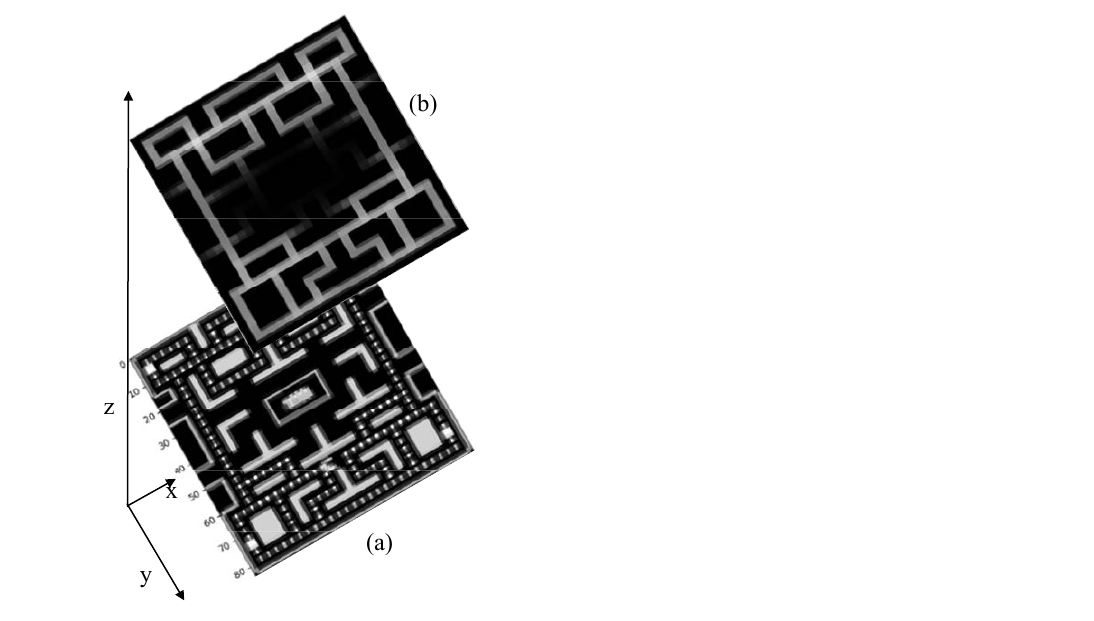
Figure 5. Dual-channel image after superimposition. ( a ) The original image. ( b ) The influence map.